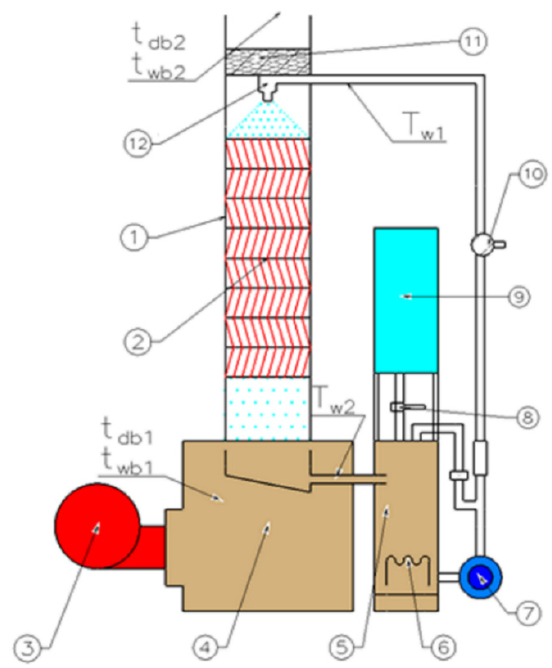
Figure 1. Schematic diagram of wet cooling tower.